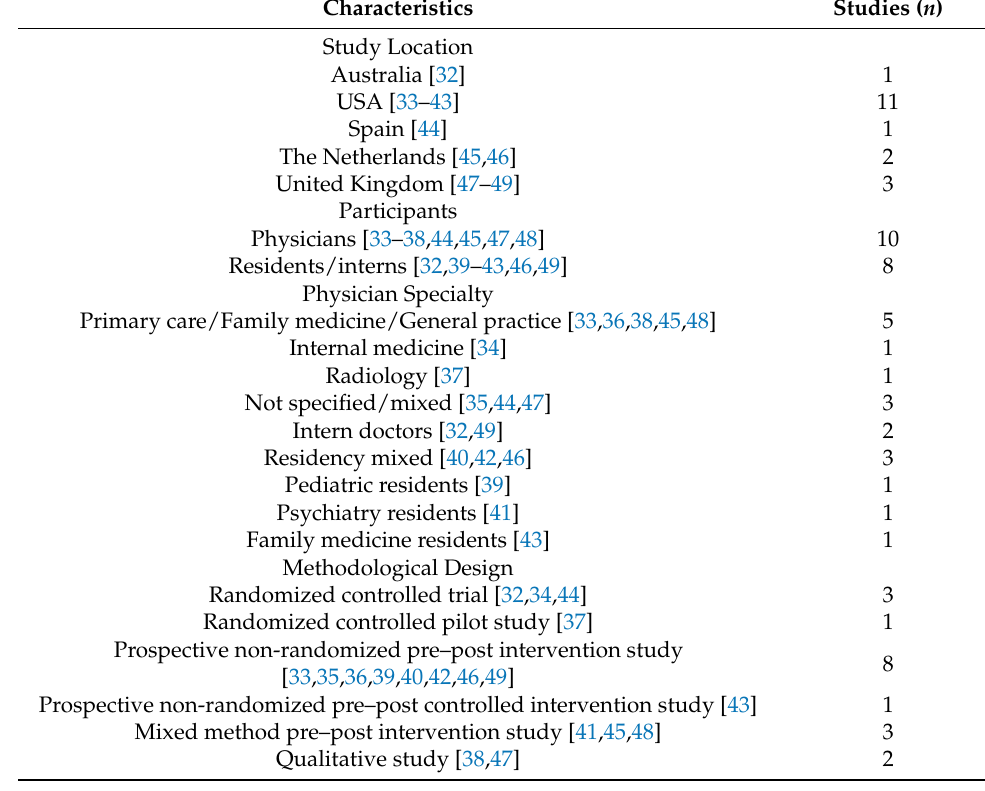
Table 1. Characteristics of reviewed